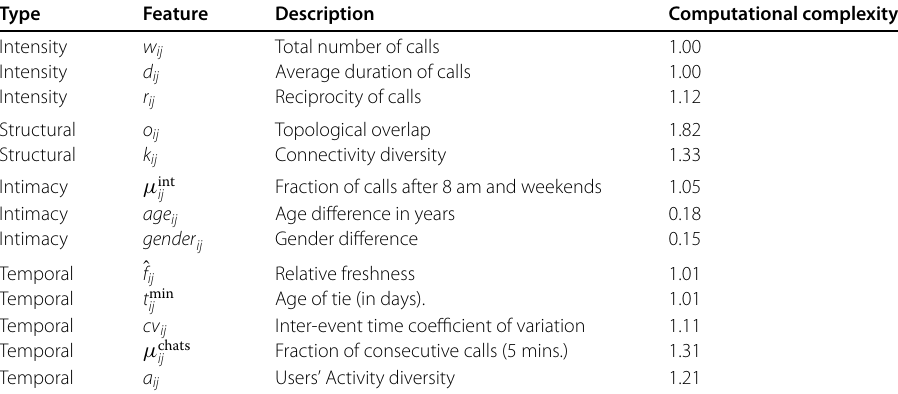
Table 1 Features of ties between user i and j considered to characterize the dynamical strength (persistence) of the ties, including their (normalized) complexity measured in computational time Type Feature Description Computational